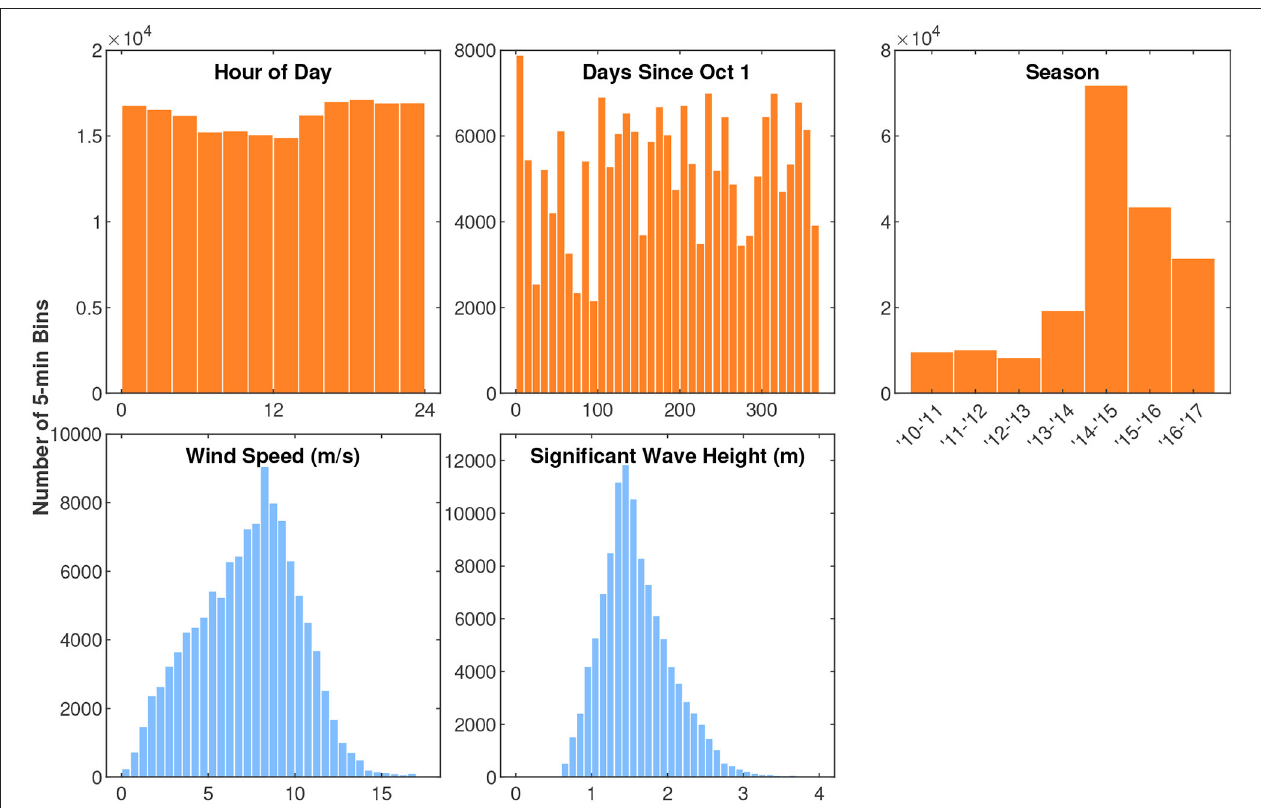
FIGURE 7 | Histograms of the independent variables observed at all times when there was recording effort. The y-axis counts are the number of 5-min bins. As in Figure 4 , time variables are shown in orange and environmental variables are shown in blue. Hour of Day is in local Hawaii Standard Time. The x-axes limits for these plots match the corresponding plots in Figure 4